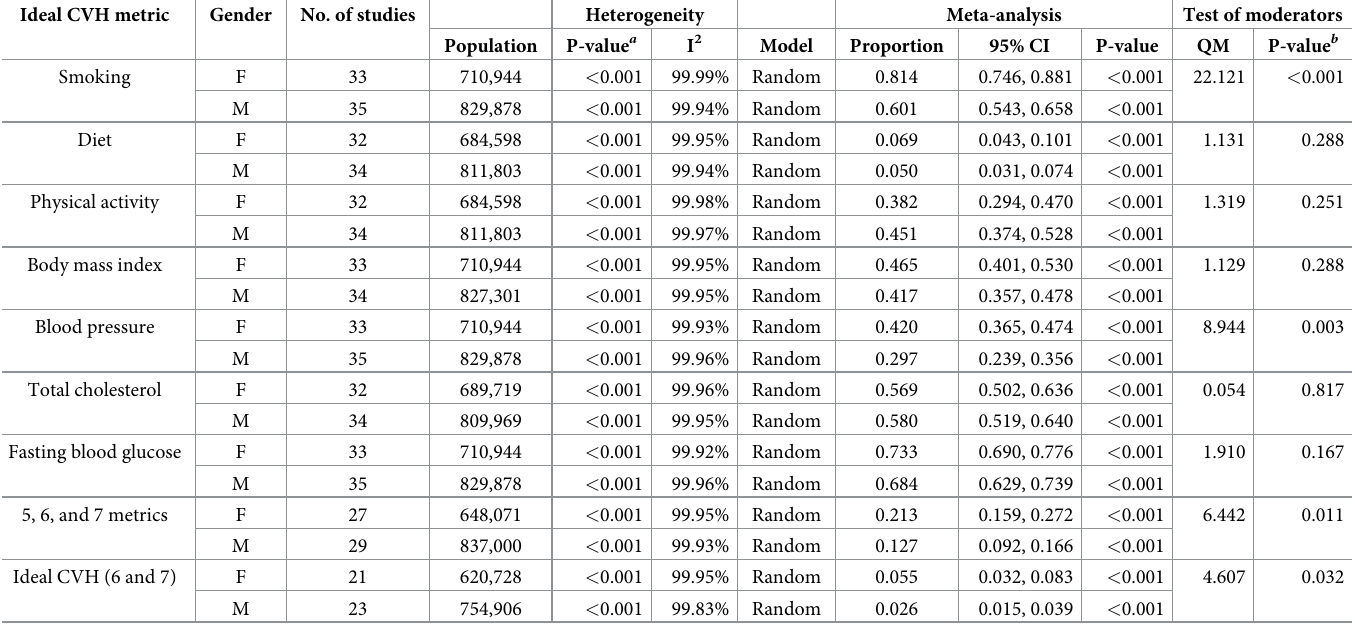
Table 2. Moderator (subgroup) analyses of ideal cardiovascular health metrics by gender.